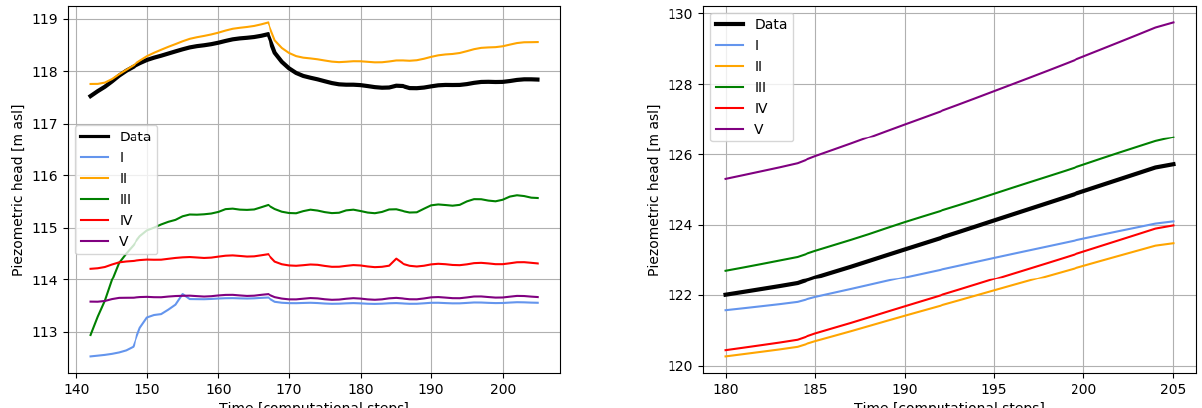
Figure 13: Results of piezometric head in piezometer P3 (left) and P4